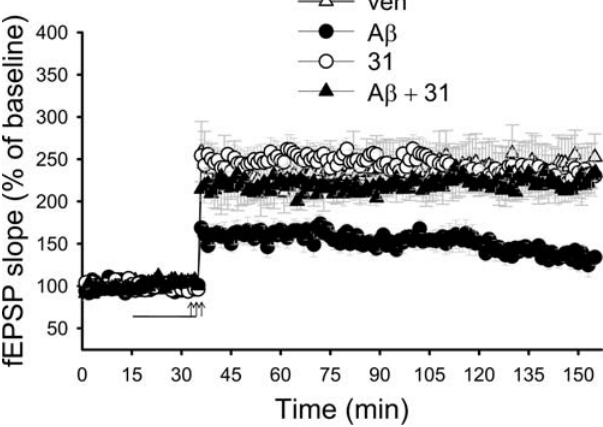
Figure 6. LM11A-31 rescues the deficit in CA1-LTP in A b - treated hippocampal slices. Extracellular field excitatory postsynap- tic potential (fEPSP) was measured as described in Methods. Arrows indicate tetanus application. The horizontal bar indicates the period during which A b and/or LM11A-31 were added to the bath solution. A b did not affect baseline transmission. Application of LM11A-31 (100 nM) rescued A b -induced impairment of LTP without affecting baseline transmission. The values for the last data point in the graph are as follows: vehicle (veh, n=8) 252.4 6 27.6%; A b (n=7) 134.0 6 9.3%; LM11A-31 (n=7) 230.2 6 24.3%.; A b + LM11A-31 (n=7) 233.6 6 17.6%. Vehicle vs. A b , p=0.02; A b vs. A b + LM11A-31, p=0.0006; vehicle vs. LM11A-31,